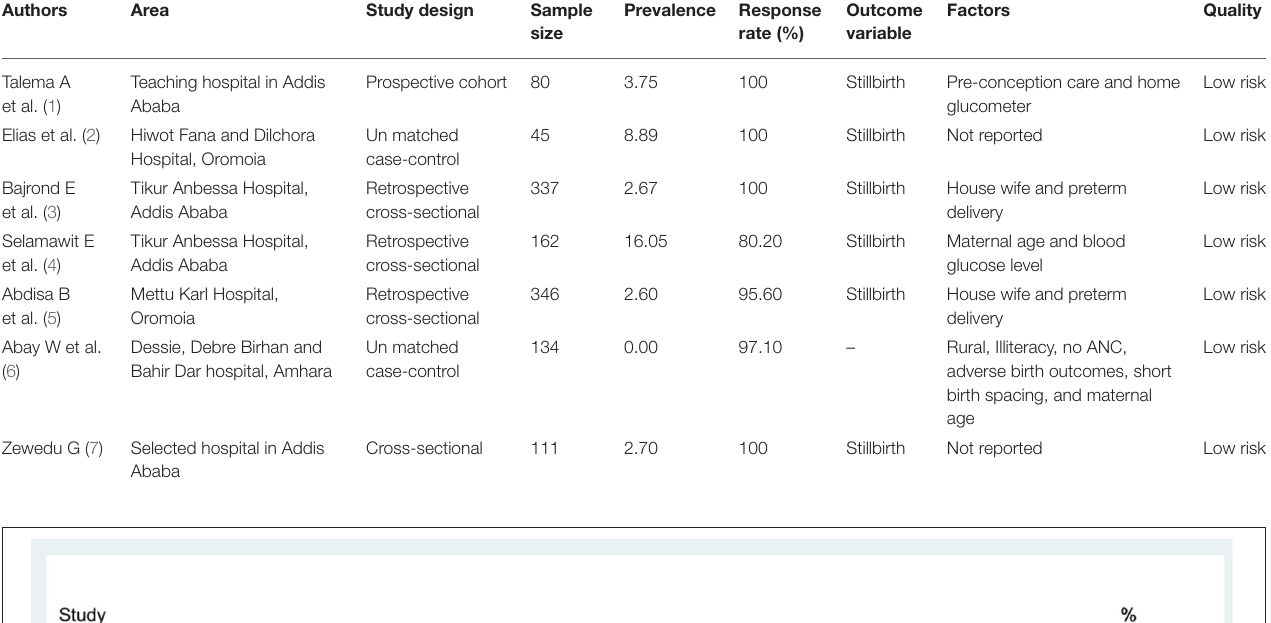
TABLE 4 | Study characteristics included in systematic review and meta-analysis of stillbirth and determinants among diabetes mothers in Ethiopia, 2020.